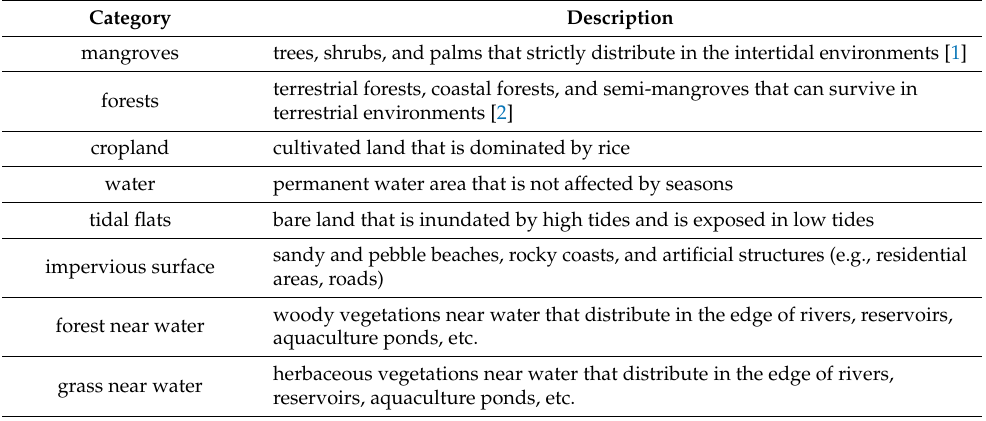
Table 3. The new classification scheme with consideration of the non-mangrove vegetation near